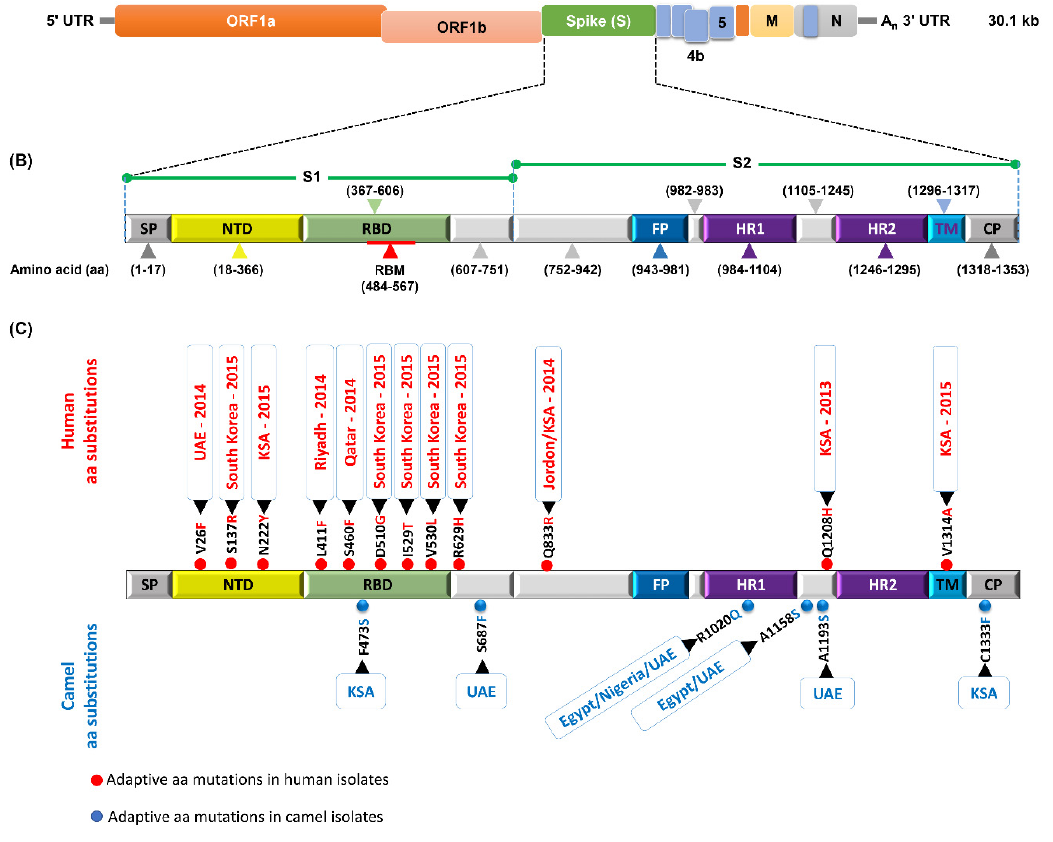
Figure 3. Schematic diagram of the MERS-CoV genome and naturally selected aa substitutions in spike protein. ( A ) The genomic structure of MERS-CoV (30.1 kb in length), illustrating sub-genomic viral RNA transcripts. ( B ) Schematic structure of the MERS-CoV S protein and its functional domains, including the N-terminal domain (NTD), receptor-binding domain (RBD), receptor-binding motif (RBM), fusion peptide (FP), heptad repeat region 1 and 2 (HR1 and HR2), transmembrane region (TM), and cytoplasmic tail (CP). ( C ) Since the first documentation of MERS-CoV in 2012 in KSA, the virus circulated in camels and occasionally humans to naturally acquire distinct adaptive amino acid (aa) substitutions.